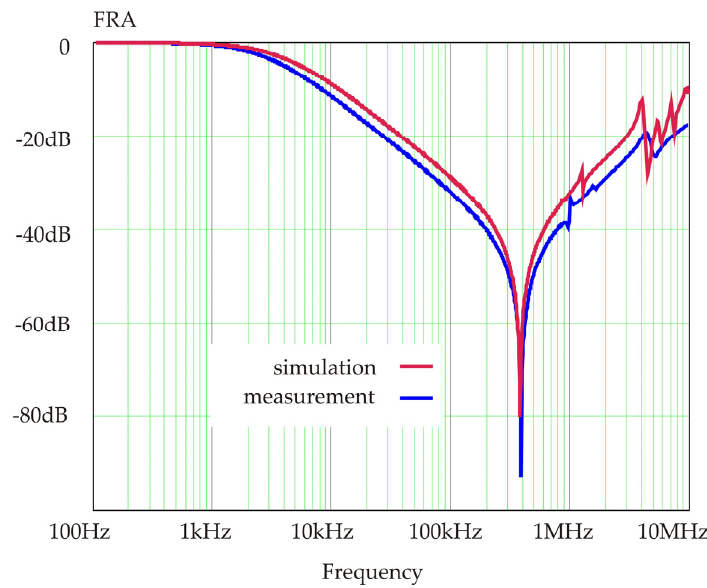
Figure 8. Test results obtained for air-cored coil with 54 serial connected turns.